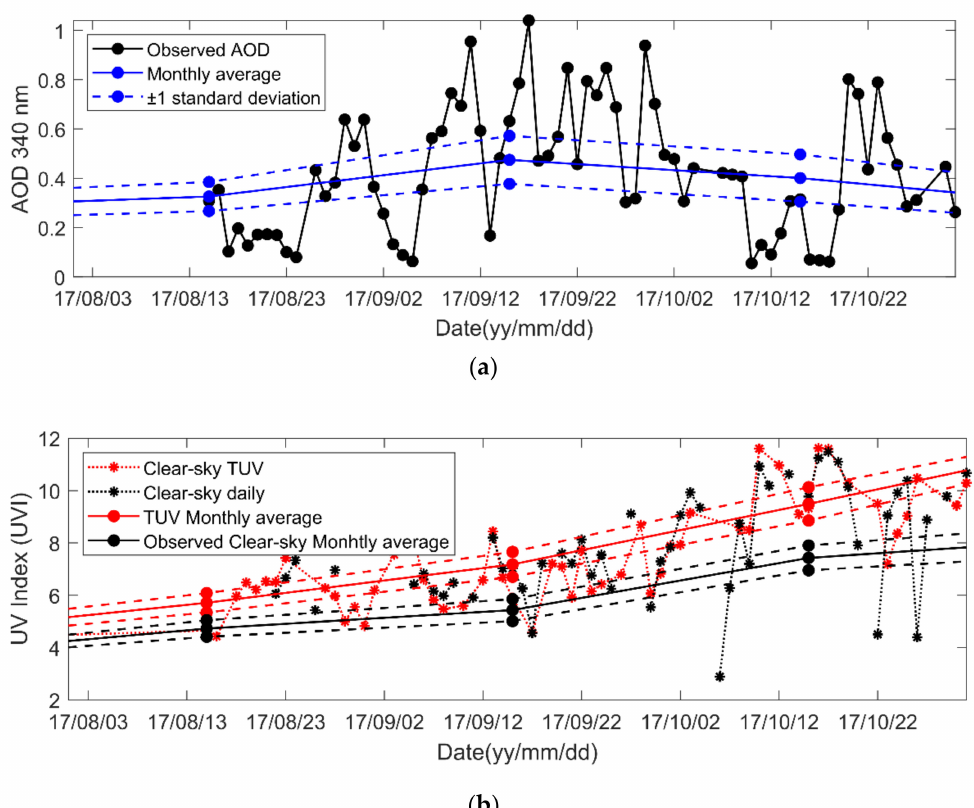
Figure 5. ( a ) Daily AOD values at 340 nm from August to October 2017 as recorded by the AERONET station at the CSIR and the monthly AOD averages and standard deviations (during the 2011–2018 period); ( b ) Daily modelled clear-sky UVI and modelled and observed clear-sky monthly averages and standard deviations from August to October